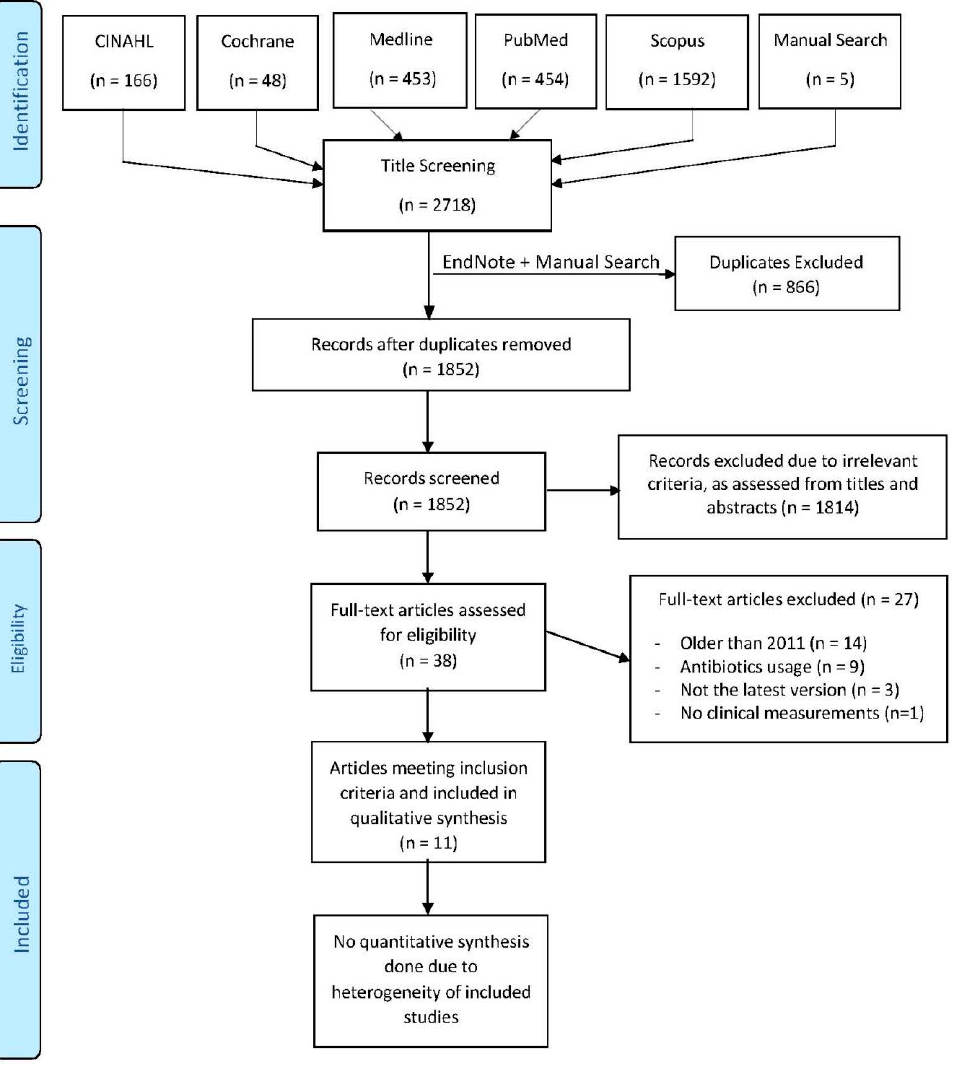
Figure 1. Prisma Flow chart of the review process.